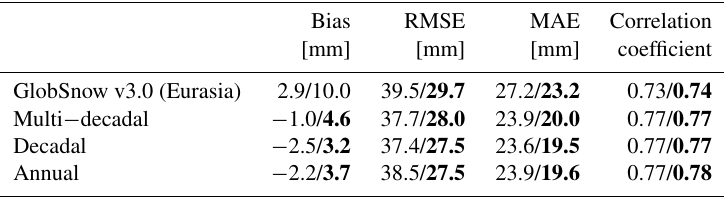
Table 2. Results of validation for different Eurasian datasets for the years 2000–2009; left values are for SWE < 500mm and bold values are for SWE < 150mm.